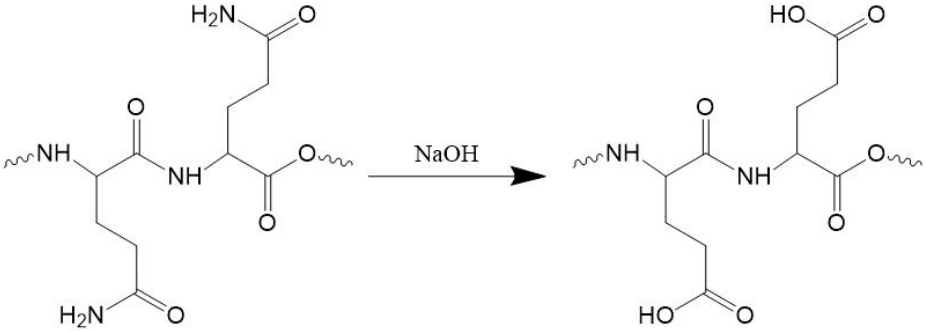
Figure 1. Schematic diagram of